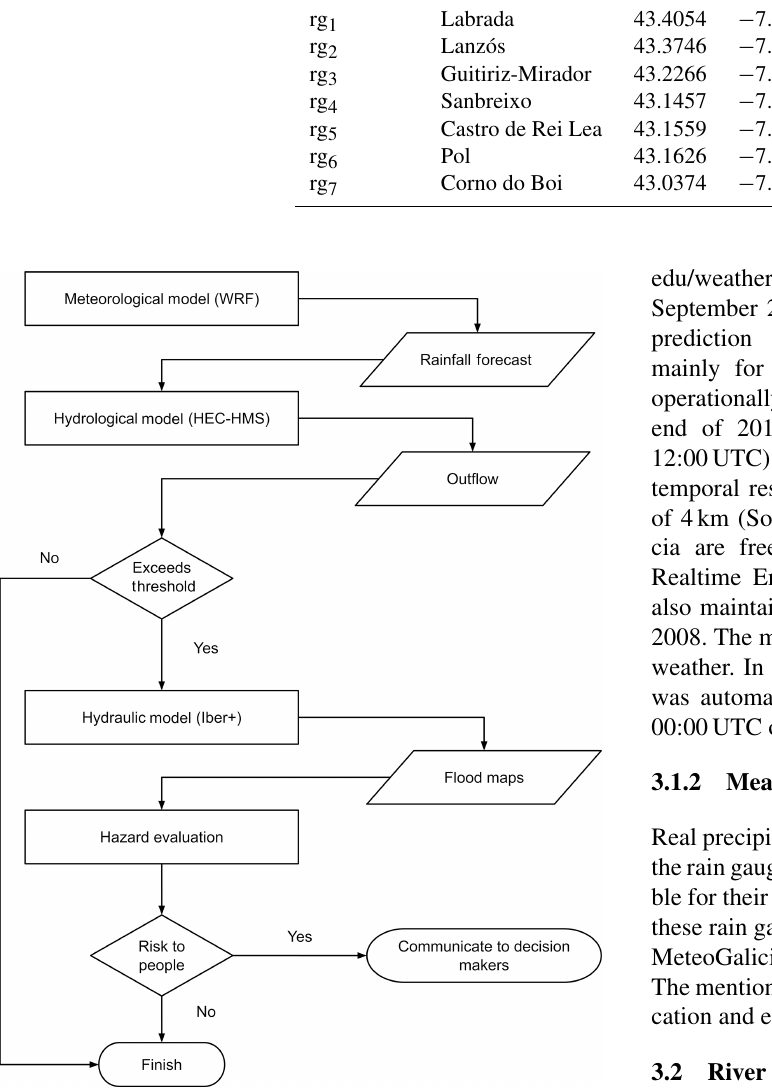
Figure 2. Flow chart of the proposed